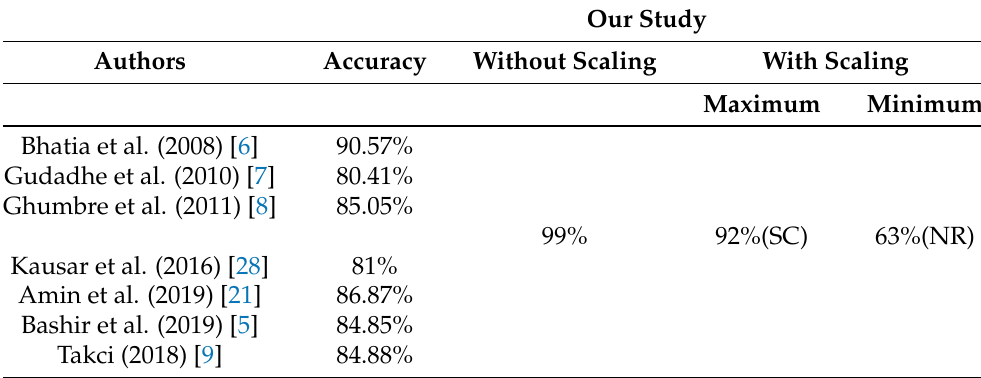
Table 12. Comparison with previous study—SVM.